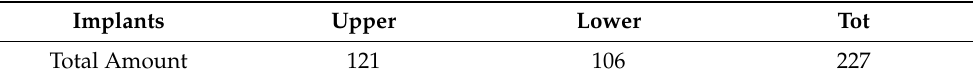
Table 1. Total amount of implants with peri-implantitis. Implants Upper Lower Tot Total